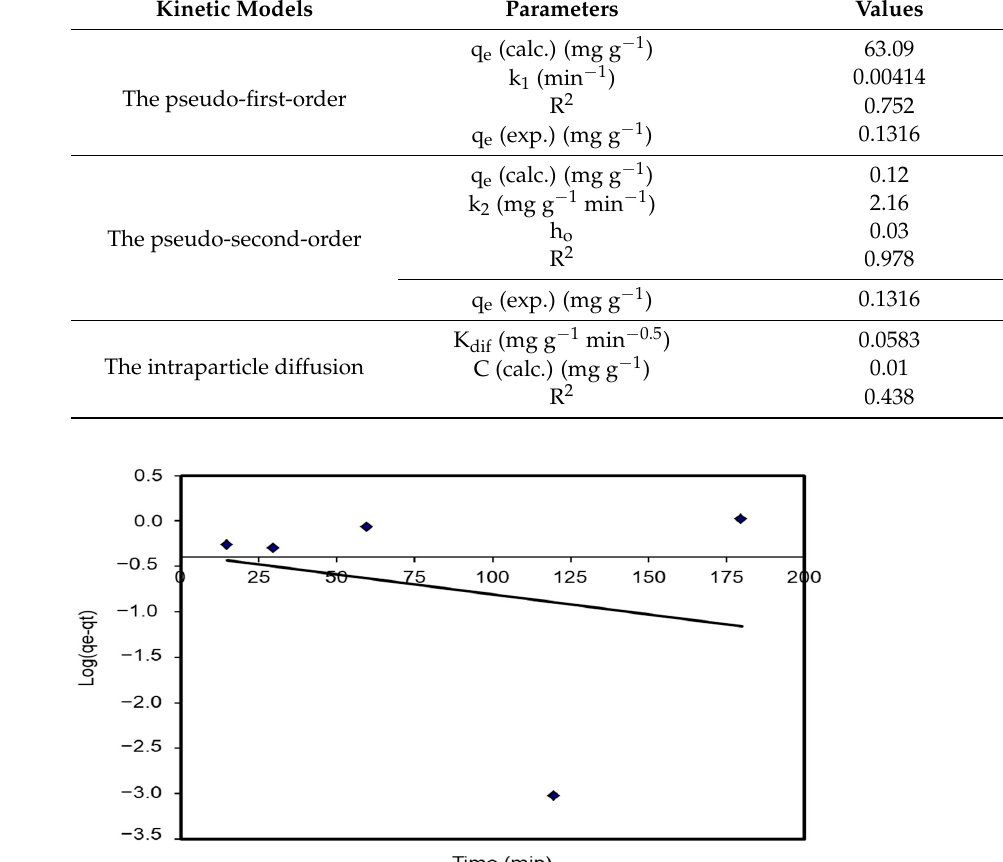
Table 5. The calculated values of kinetic parameters of the adsorption of CVD onto S. costatum .